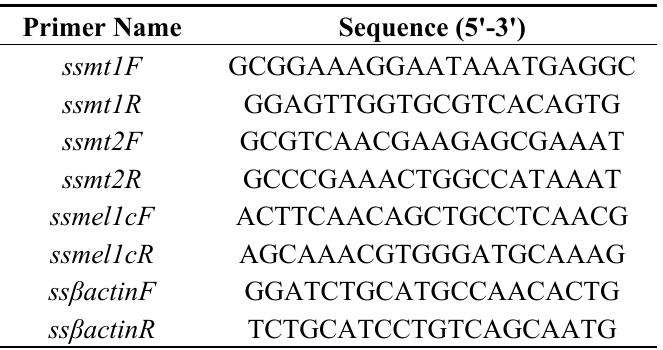
Table 2. Sequences of the primers